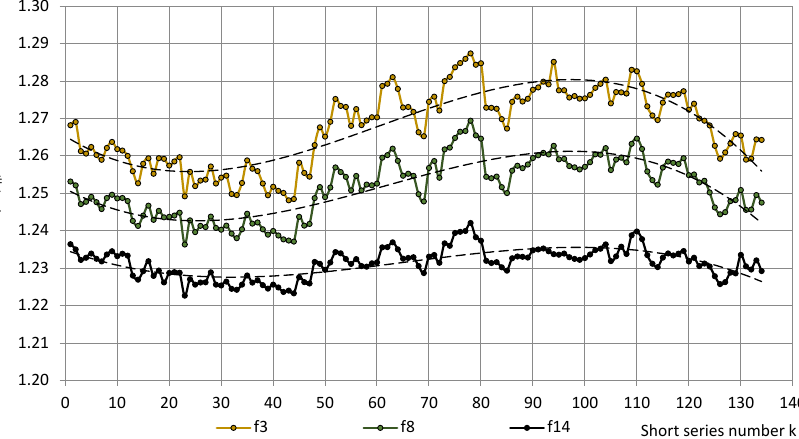
Figure 3. The permittivity ε of PU SikaBlock ® -M150 foams (density of 144 kg/m 3 ) in the short series at frequencies f 3 = 40 Hz (beige), f 8 = 1280 Hz (green), and f 14 = 81,920 Hz (black).